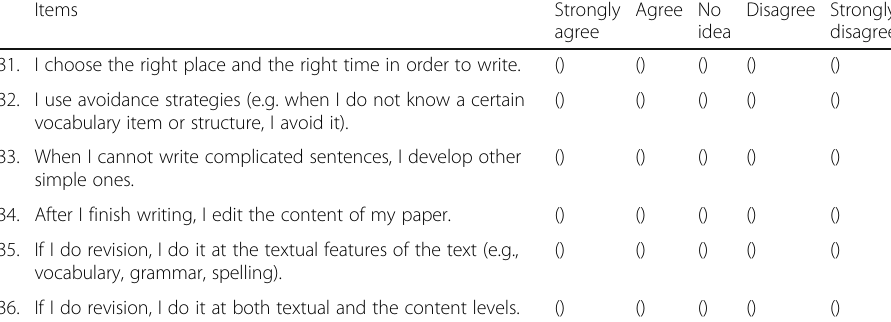
Table 7 MAWQ (Metacognitive Awareness Writing Questionnaire) (Continued) Items Strongly 31. I choose the right place and the right time in order to